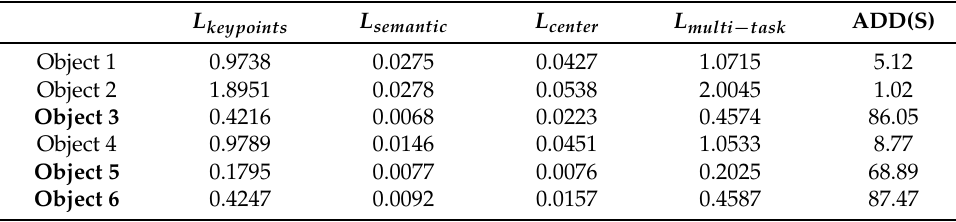
Table 1. Losses and evaluation of perception submodules on ADD(S) obtained in the test. Symmetric objects are in